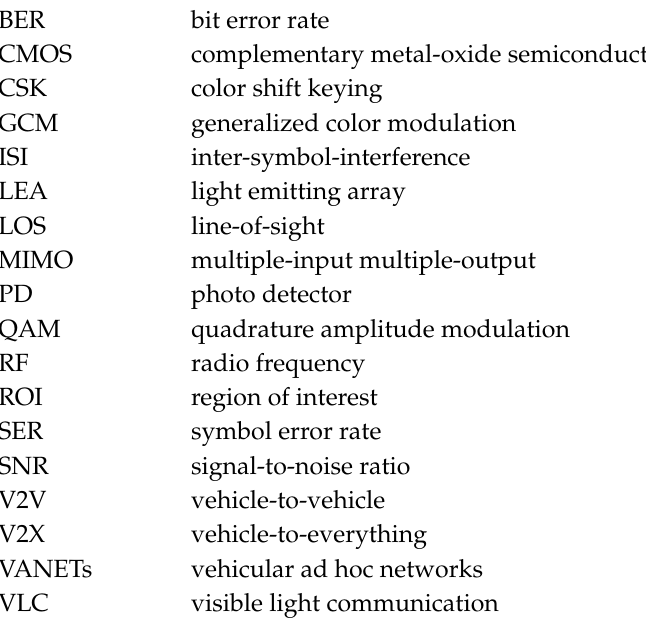
Figure S1. The illustration of V2V communication using color-independent visual-MIMO.